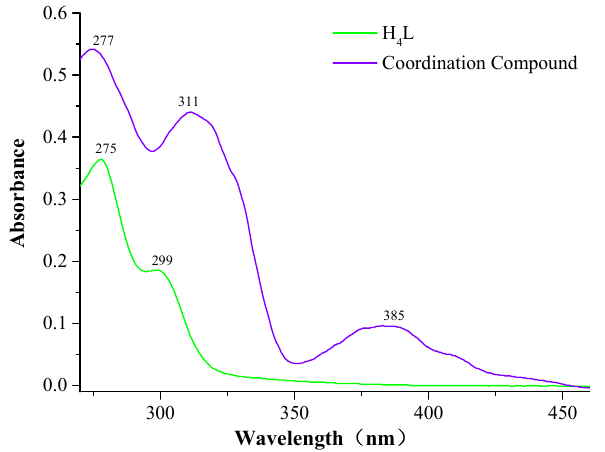
Figure 6. UV–vis spectra of H 4 L and its Co(II) coordination compound in CH 2 Cl 2 (1 ×10 −6 M).